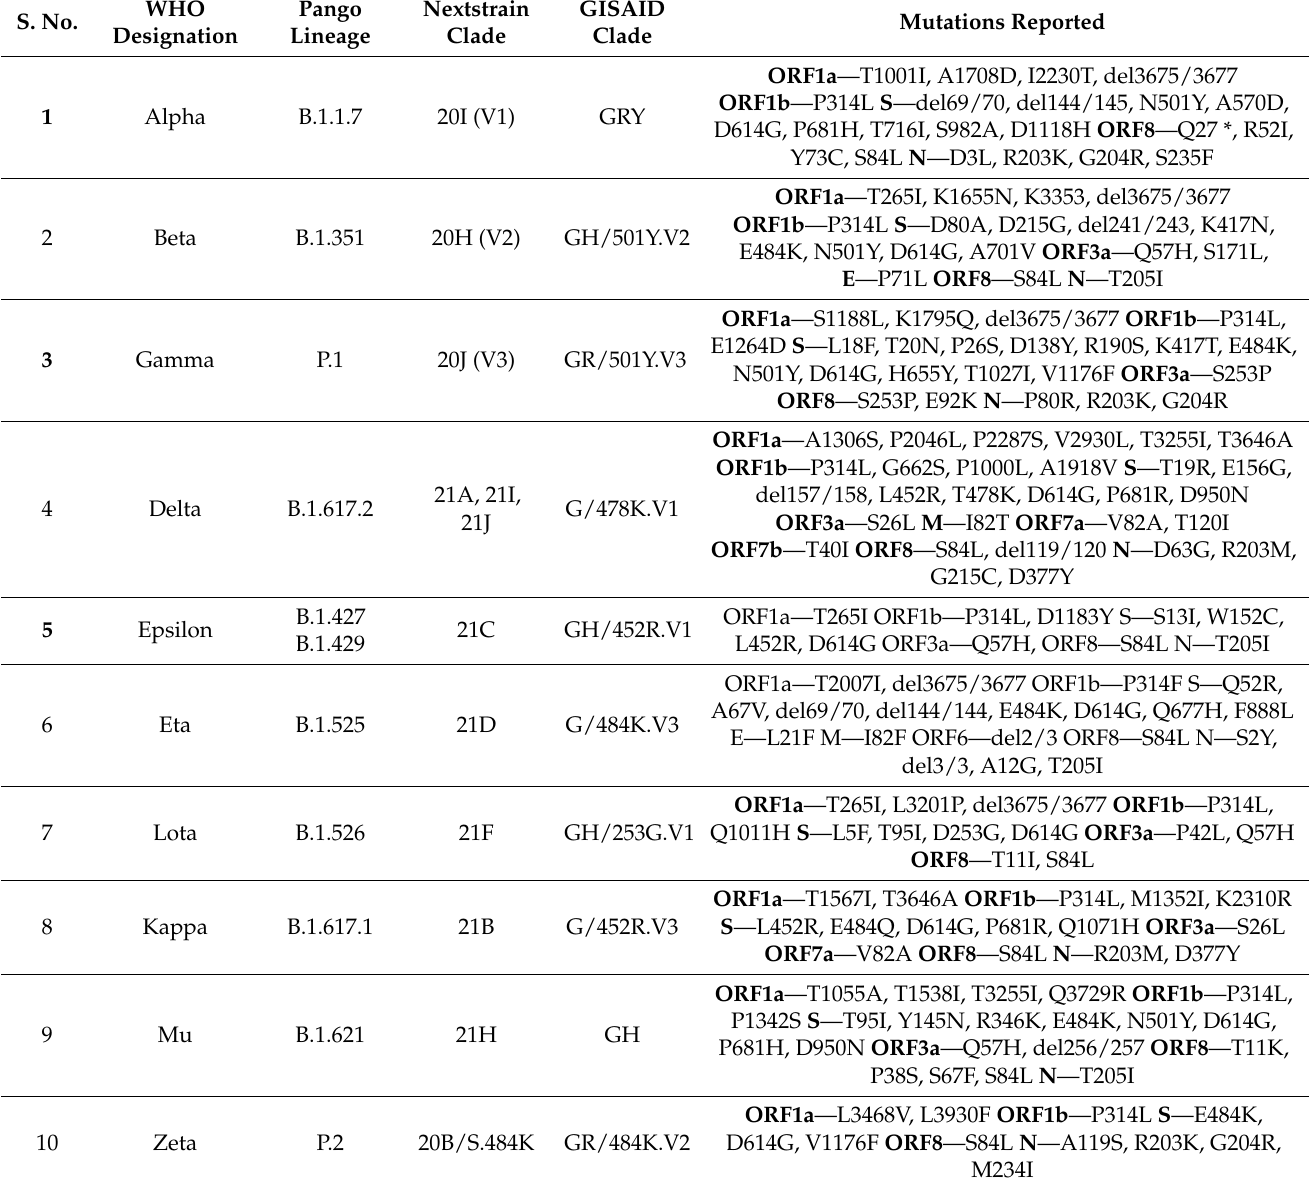
Table 4. List of current circulating Variants Being Monitored (VBM) and mutations